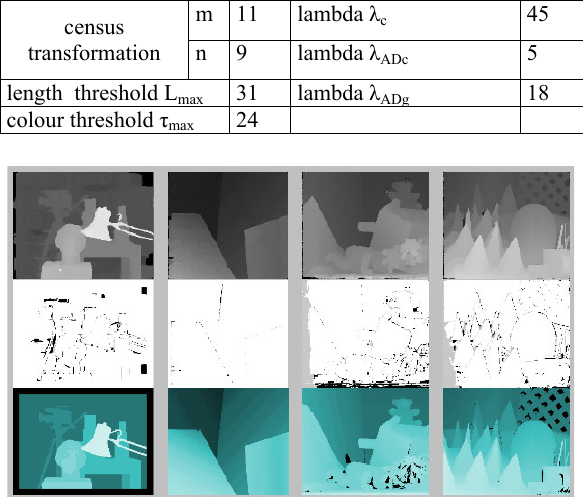
Table 1. Parameters values used in all dataset evaluations.